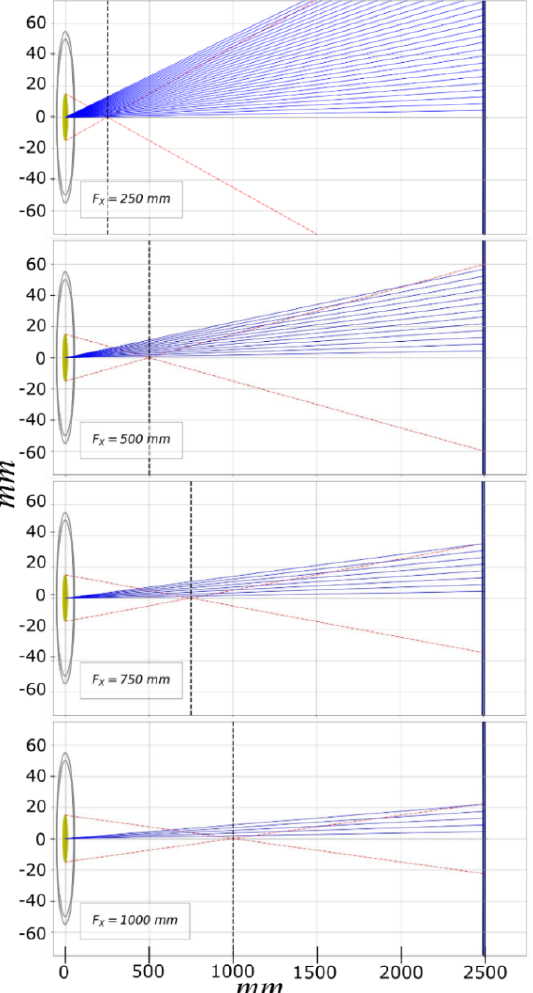
Fig. 3. Different slit configurations for fixed 2F variable F from 250 to 1000 mm . The solutions for r X are the intersections of the radial blue lines (having an angle 𝜙 ) with the red-dashed focal